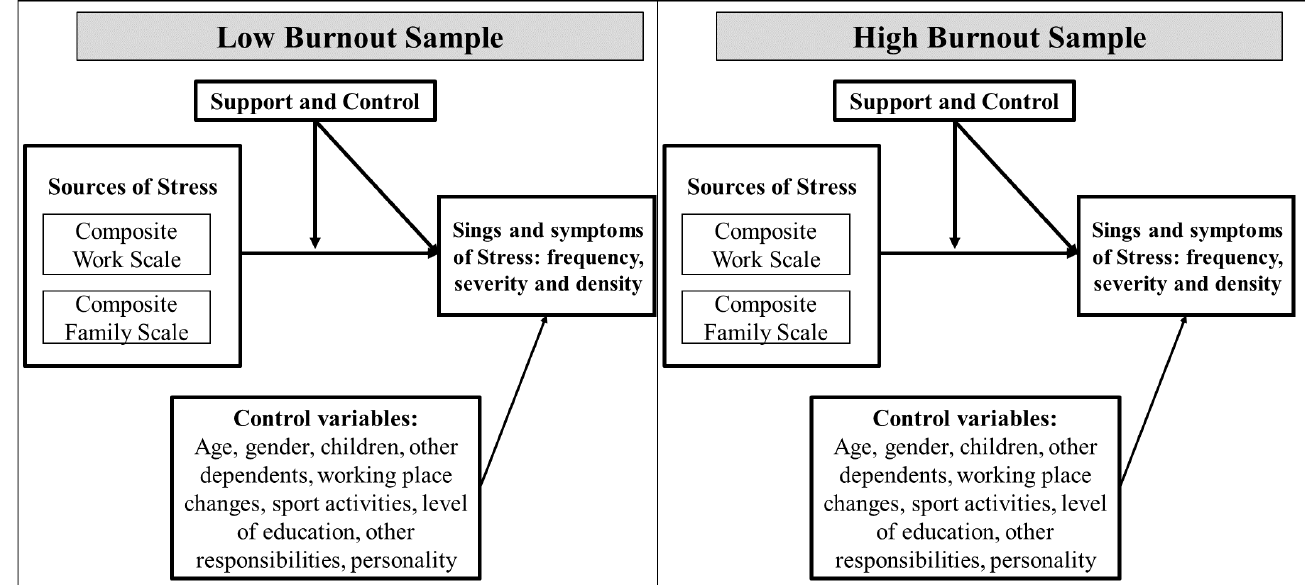
Figure 1. The proposed Conceptual Model.